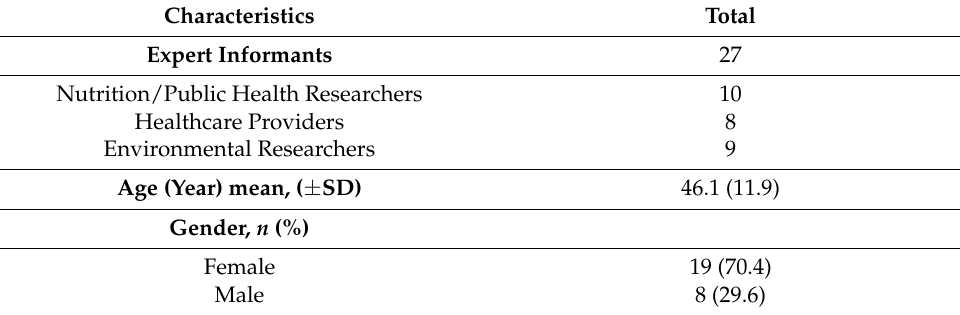
Table 2. Demographic Characteristics of Study